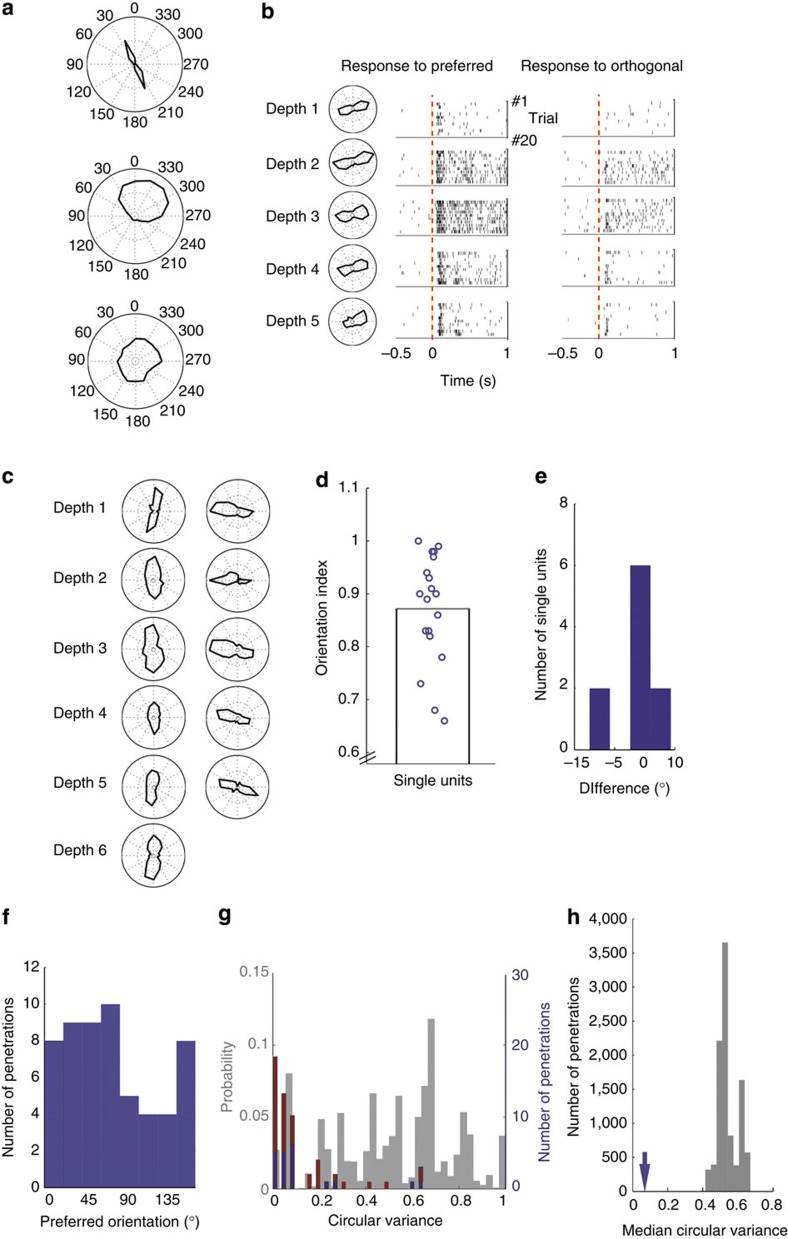
Vertical grouping of orientation preference in the superficial layer of the mouse superior colliculus.(a) Examples of orientation and direction tuning. (b) Orientation tuning across different channels on a laminar electrode with 50 μm spacing. Right panels show raster plot of spikes around the onset of all trials to the preferred and orthogonal orientations. (c) Example penetrations with tungsten microelectrodes, depths are 50 μm apart. (d) Orientation selectivity index of 19 high waveform-amplitude single units from horizontal and vertical penetrations (9 mice). Bar indicates mean. (e) Difference of the preferred orientation of the 10 single units (5 mice) encountered on vertical penetrations to the mean preferred angle of all units on the penetration. (f) Histogram of the circular mean of the orientation preference for all 57 penetrations (14 mice). (g) Histogram of the circular variance of orientation preference in individual penetrations with a silicon probe (blue, n=20) or tungsten microelectrode (red, n=37), plotted on the probability distribution generated by shuffling all recorded preferences over all penetrations (grey). (h) Median circular variance for the real penetrations (arrow) lies far below medians for shuffled data.